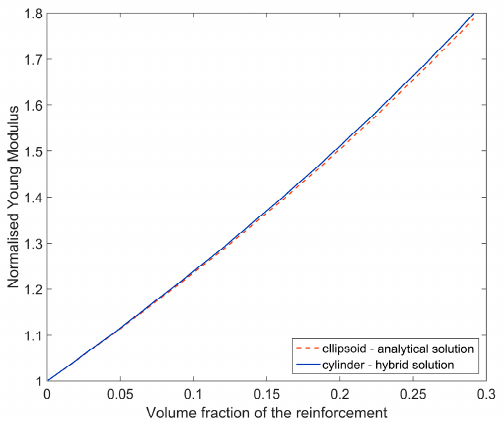
Figure 5. Normalized Young moduli in terms of volume fraction of the reinforcement determined by using pure analytical and hybrid method.